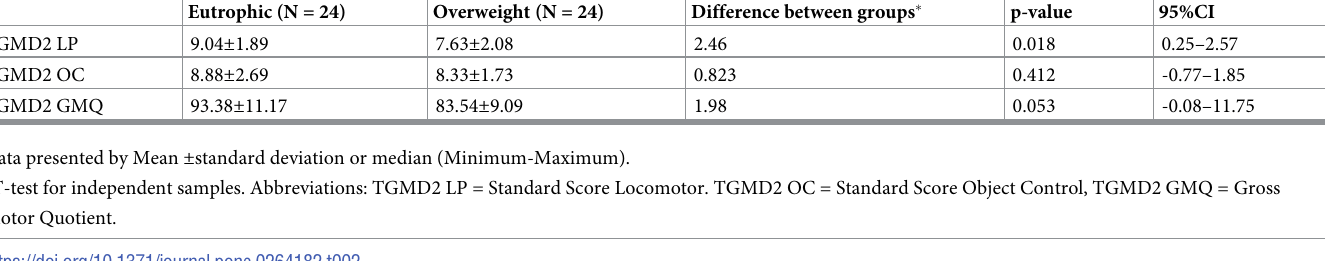
overweight/obese group had lower LP scores (Table 2). The post-hoc analysis, considering an effect size of 0.70 (alpha value = 0.05), revealed a large statistical power for the LP (Power = 0.96).